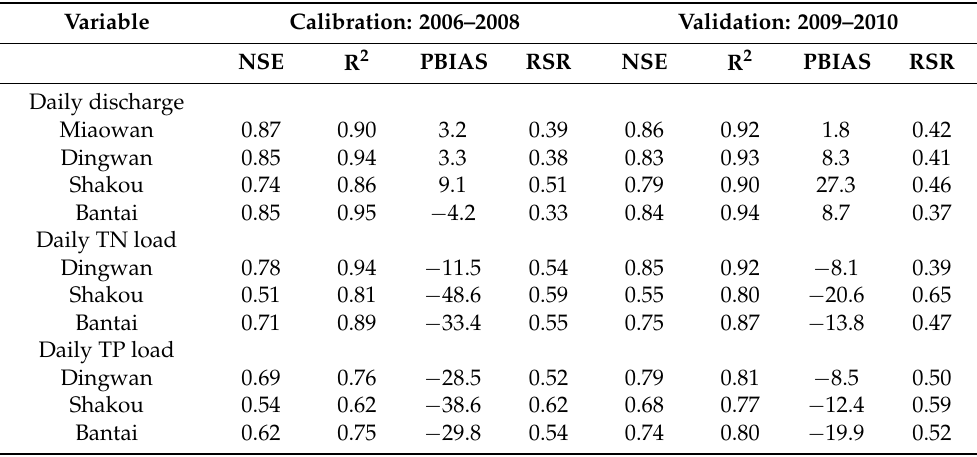
Table 5. Model evaluation statistics of daily discharge, daily TN, and TP load simulations at the